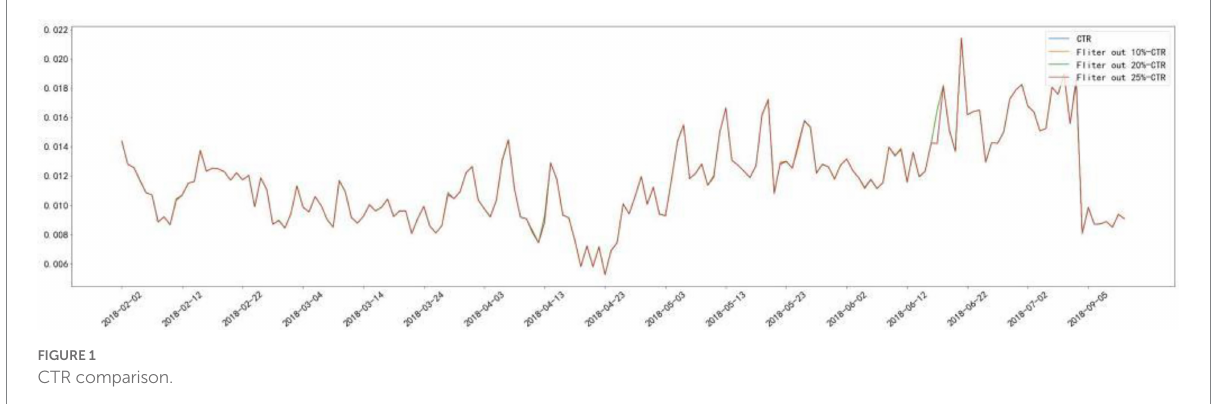
FIGURE 1 CTR comparison.